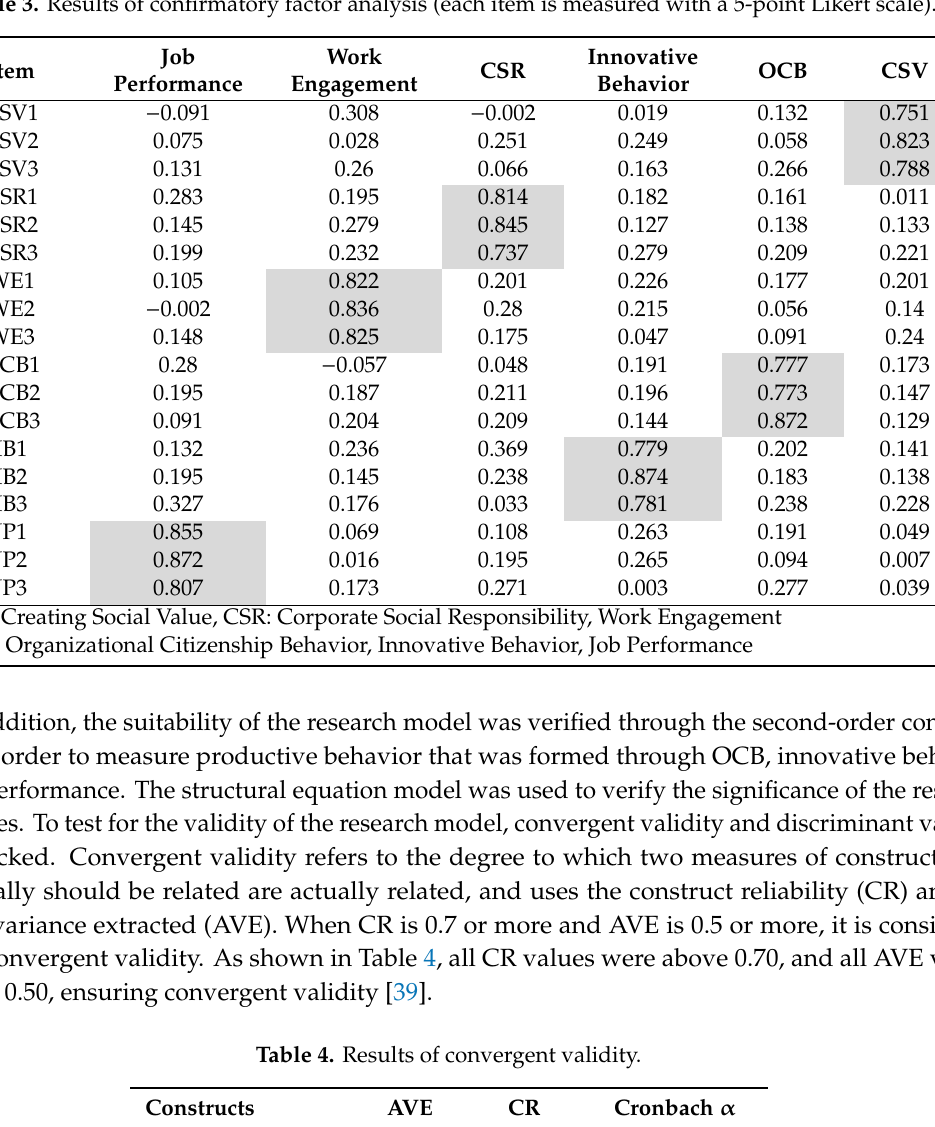
Table 3. Results of confirmatory factor analysis (each item is measured with a 5-point Likert scale).